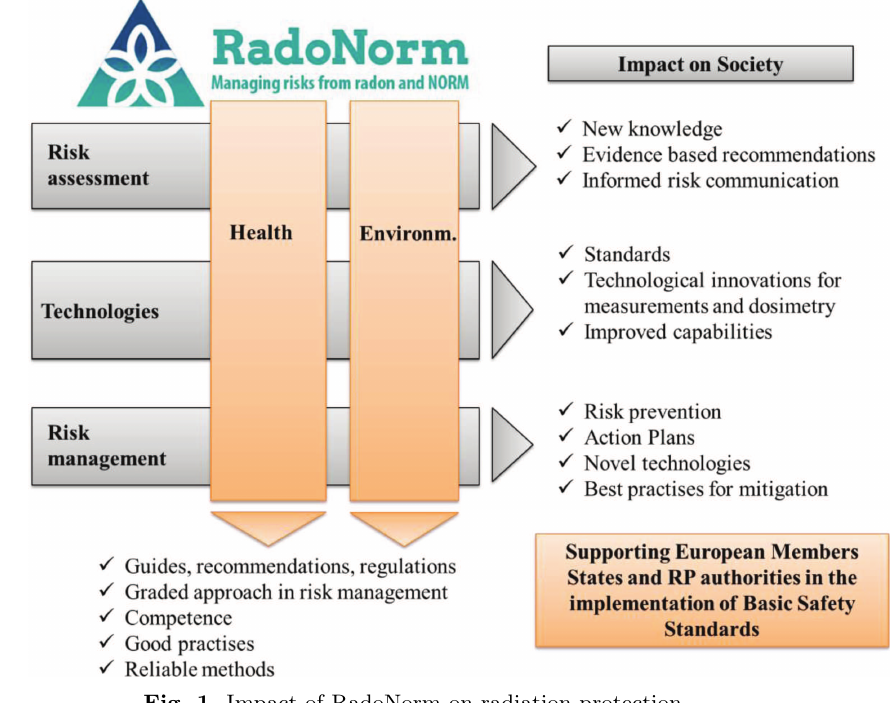
Fig. 1. Impact of RadoNorm on radiation protection.